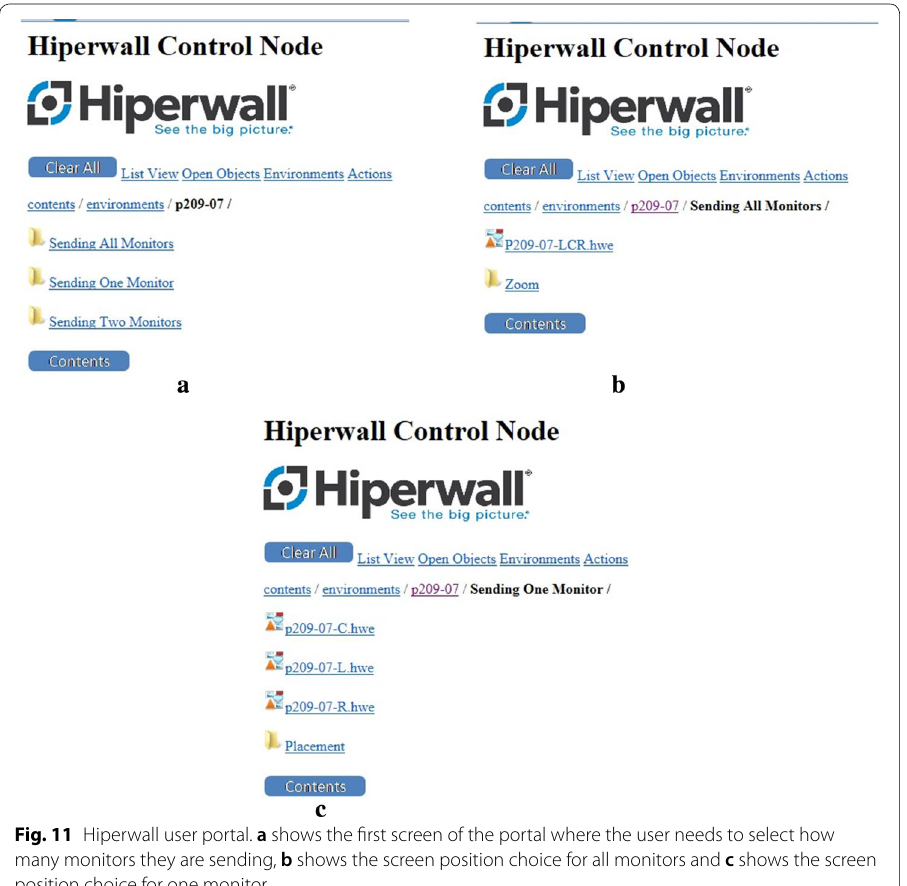
position choice for one monitor